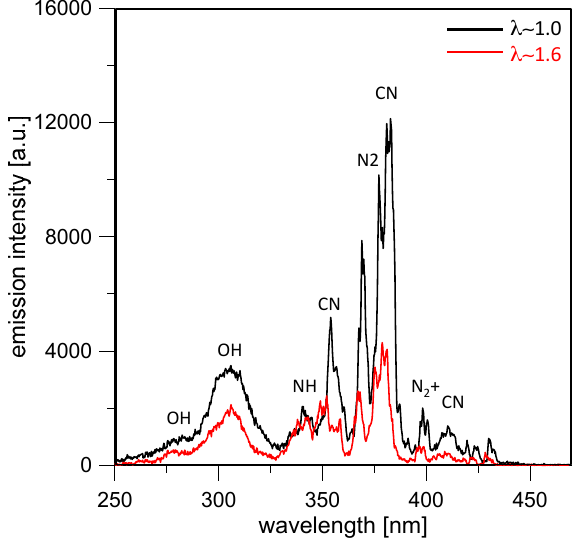
Figure 11. UV-visible spectra detected in the region near the spark plug (Loc. 4) at 2 CAD ASOS for λ = 1.0 and λ = 1.6.